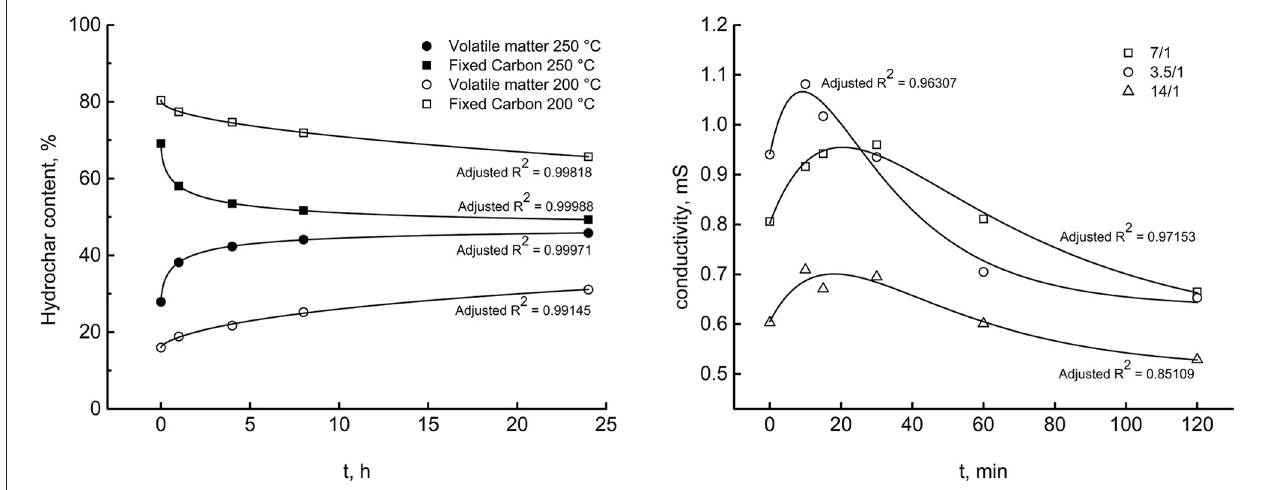
FIGURE 6 | Synopsis of all the estimated parameters. Percent deviations between estimates: NLS, non-linear least-squares; MCMC, Markov chain Monte Carlo.